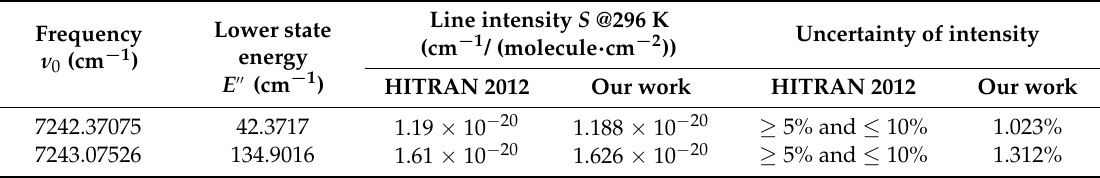
Table 2. H 2 O absorption line